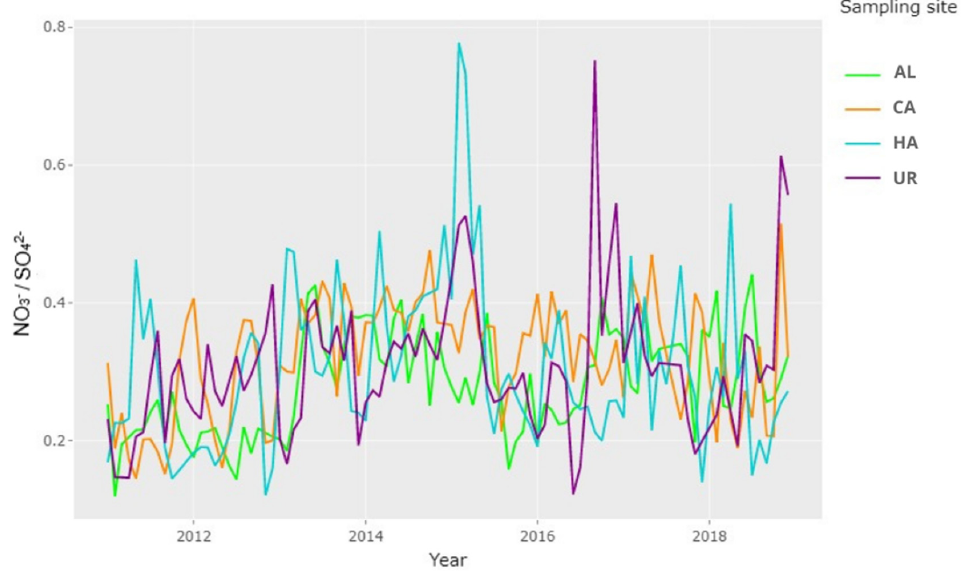
Figure 4. Monthly NO 3 − − SO 42 − ratio variation for the sampling sites, 2011–2018 .